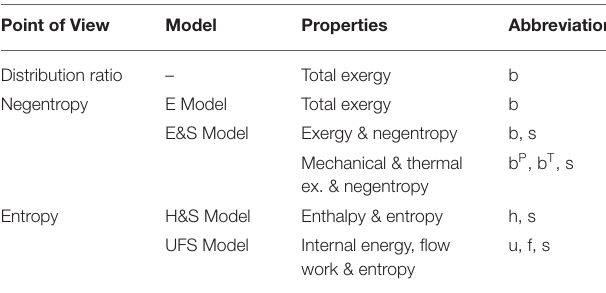
TABLE 1 | Required thermodynamic properties for each thermoeconomic